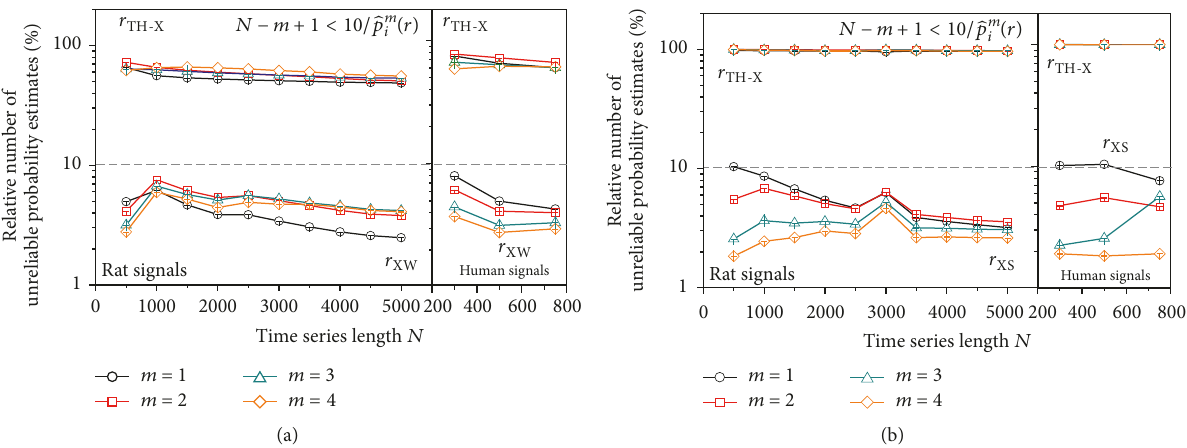
} and weak criterion is applied; (b) 𝑟 ∈ {𝑟 ,𝑟 } XS TH-X TH-X